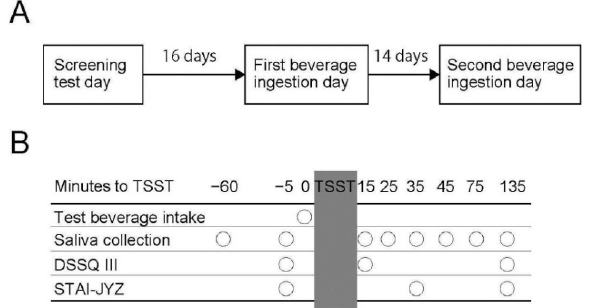
Figure 1. Schematic representation of test schedule. ( A ) Whole test schedule of this study. ( B ) Schedule of the test day. Timing of test beverage ingestion, saliva collection and questionnaire are shown by circles. DSSQIII, Dundee Stress State Questionnaire III; STAI-JYZ, State-Trait Anxiety Inventory-Form JYZ; TSST, Trier Social Stress Test. Table 2. Baseline characteristics of the participants for evaluation of primary endpoint.